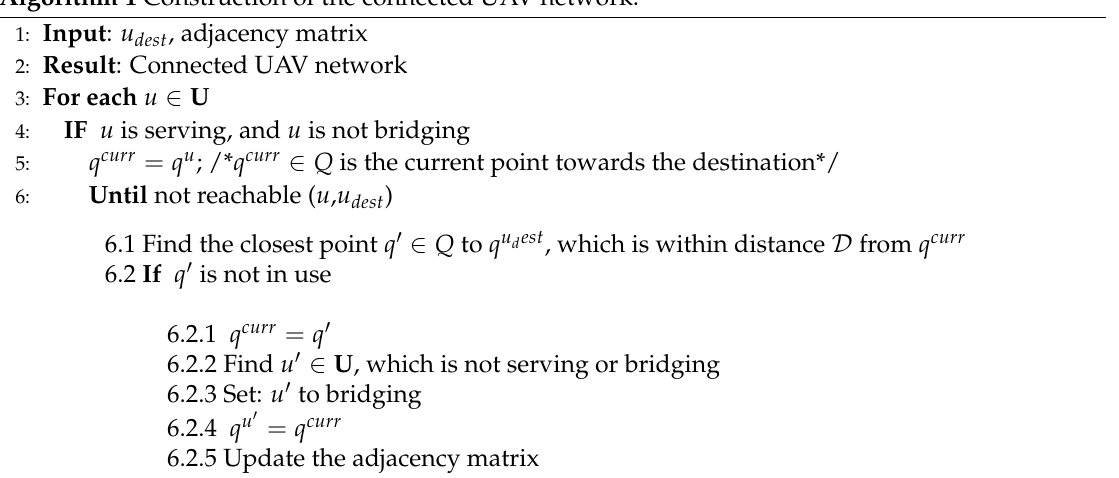
Algorithm 1 Construction of the connected UAV